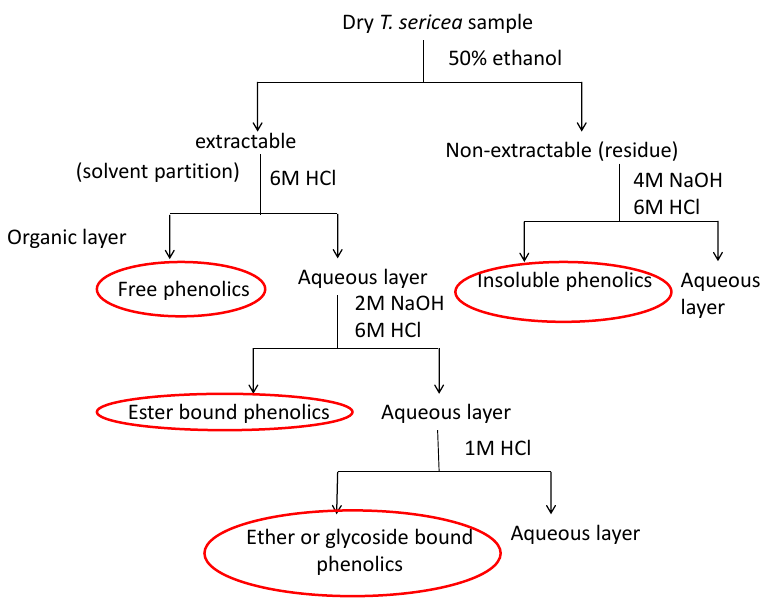
Figure 8. The flowchart indicating the extraction of free, ester, ether, and insoluble-bound phenolics.